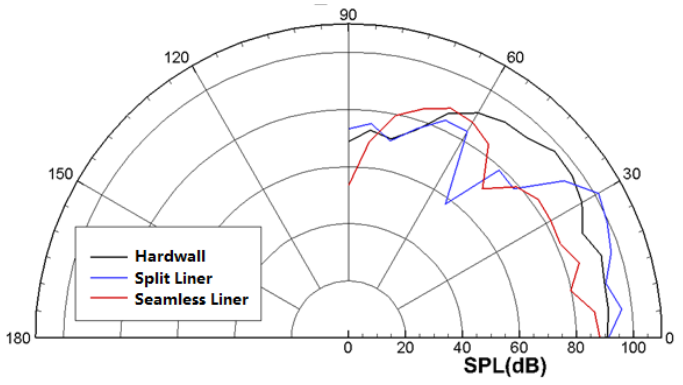
Figure 14. Acoustic directivity of (15, 0) circumferential mode at 2000 Hz.